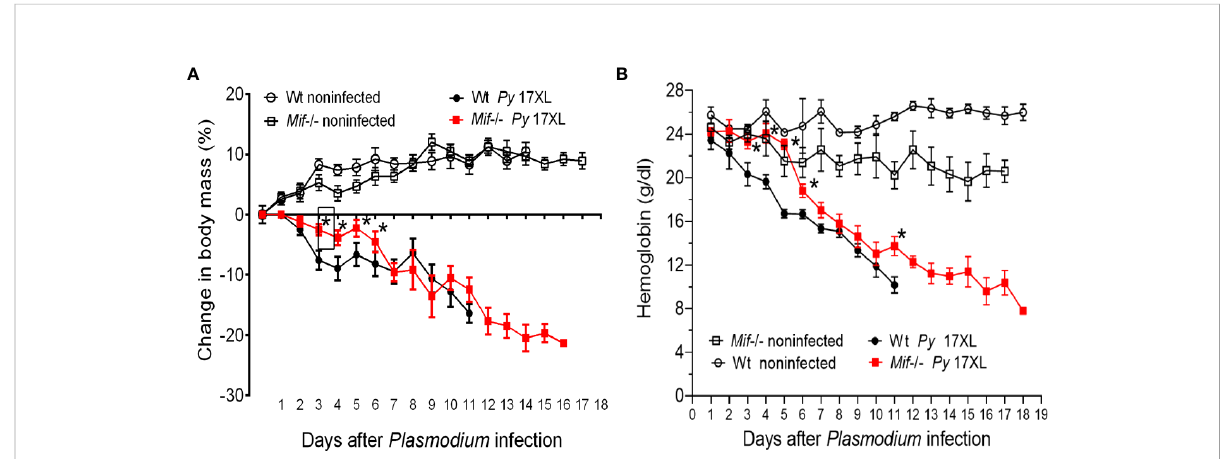
FIGURE 3 MIF delayed the development of cachexia and reduced the early loss of hemoglobin after Plasmodium yoelii 17XL infection. Wild-type and Mif -/- mice were intravenously infected with 1×10 3 Py 17XL-parasitized erythrocytes. Non infected Wt mice were used as controls. (A) Body mass change and percentage weight change were calculated using the weight of each animal at day 0. (B) Hemoglobin concentration. Data are expressed as the mean ± SEM and are representative of 2 independent experiments with at least 3 to 5 mice per group. Values of p < 0.05 were considered statistically signi fi cant (*) compared to Py 17XL-infected Wt